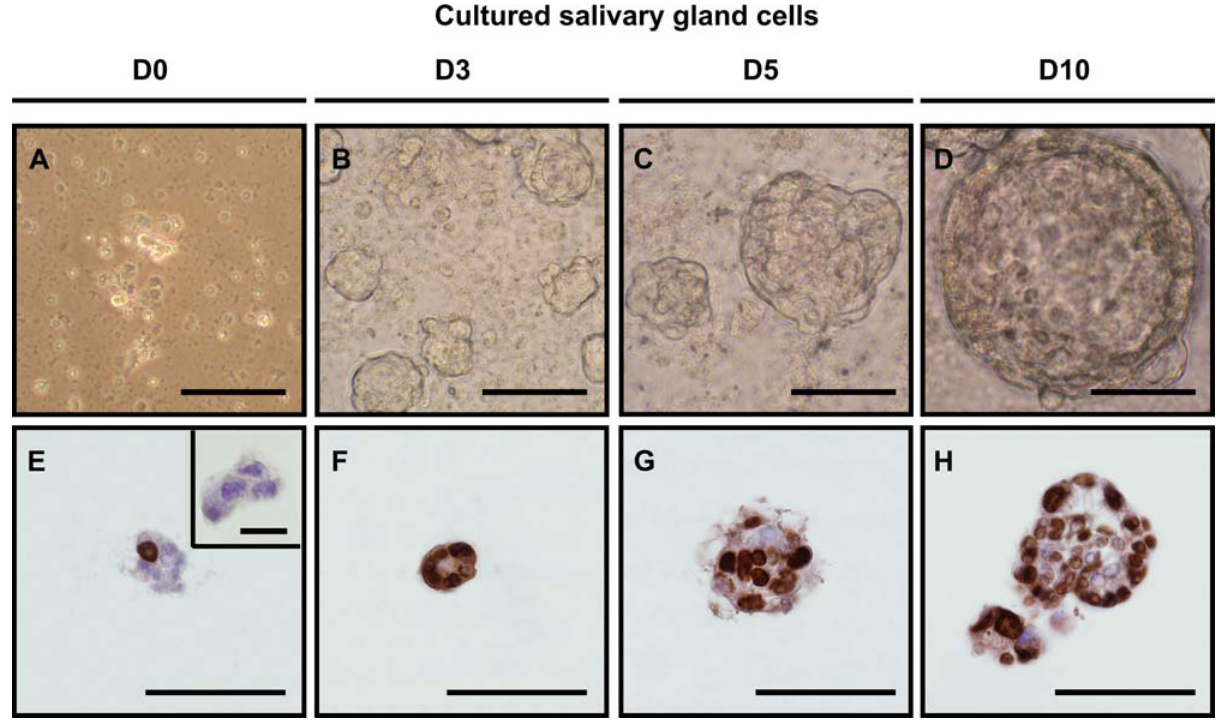
Figure 1. Invitro salisphere formation. (A) Dissociation of submandibular glands using hyaluronidase and collagenase resulted in clustered cell suspensions. 9723 6 795 spheres were formed after 2–3 days of culturing (B), which increased in size in time (C,D). BrdU incorporation indicated that the cells in the culture were actively dividing (E–H). BrdU incorporation stained in brown, nuclei in blue. Scale bar=50 m m. Inset shows negative control for BrdU, scale bar=20 m m.